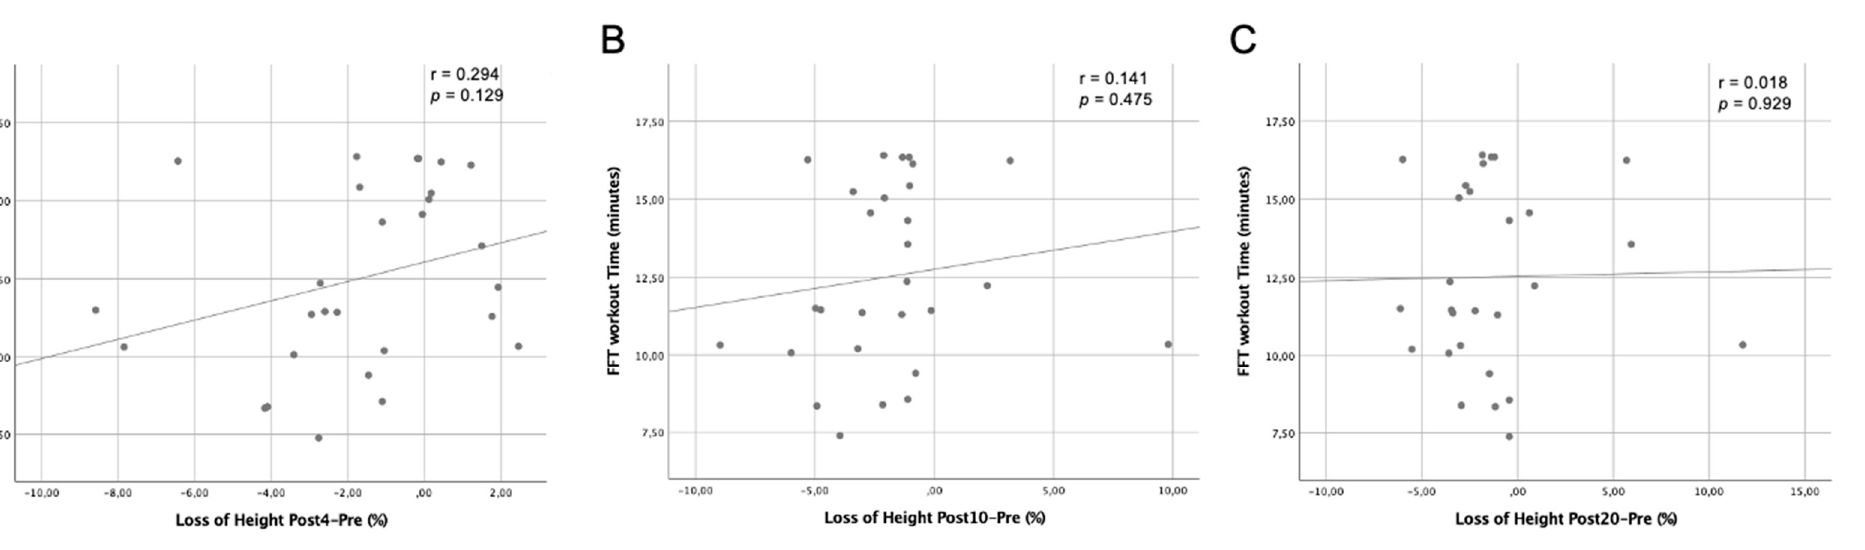
Figure 2. Correlation between FFT workout duration and loss of jump height in minutes 4 ( A ), 10 ( B ), and 20 ( C ) after the workout.